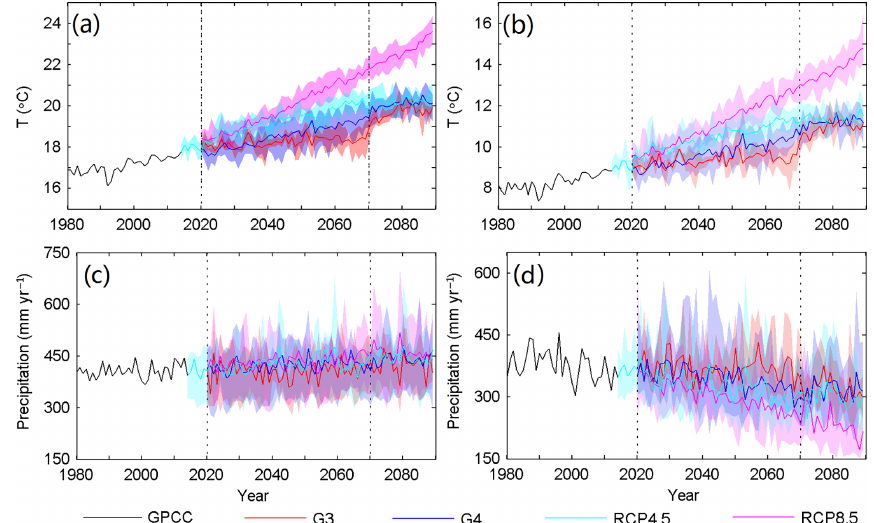
Figure 3. Time series of summer mean bias-corrected temperature (a, b) and annual precipitation (c, d) averaged over the downscaled grid (Sect. 3.2) in the whole region (a, c) and only in the glaciated region (b, d) . Note the different temperature ranges in (a, b) and precipitation ranges in (c, d) . Precipitation in (d) is the average annual solid precipitation at the ELA of each glacier in the start year of simulations, which is taken here to be representative of each glacier. The solid curves and shadings from 2013 to 2089 are the ensemble mean and the across-model spread between ensemble members for each scenario, respectively, which are colour-coded in the